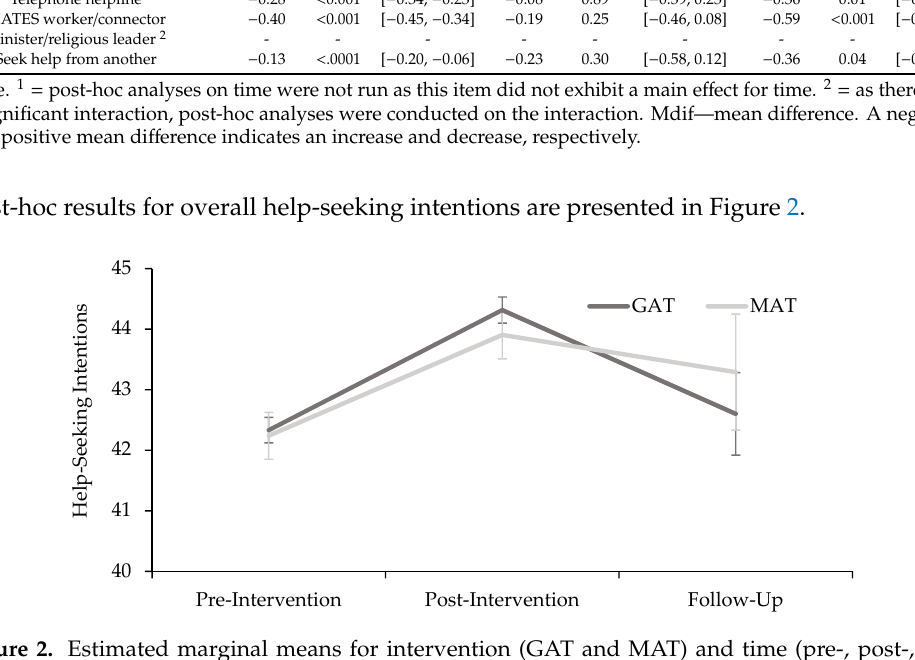
Figure 2. Estimated marginal means for intervention (GAT and MAT) and time (pre-, post-, and follow-up) on help-seeking intentions. Error bars represent standard